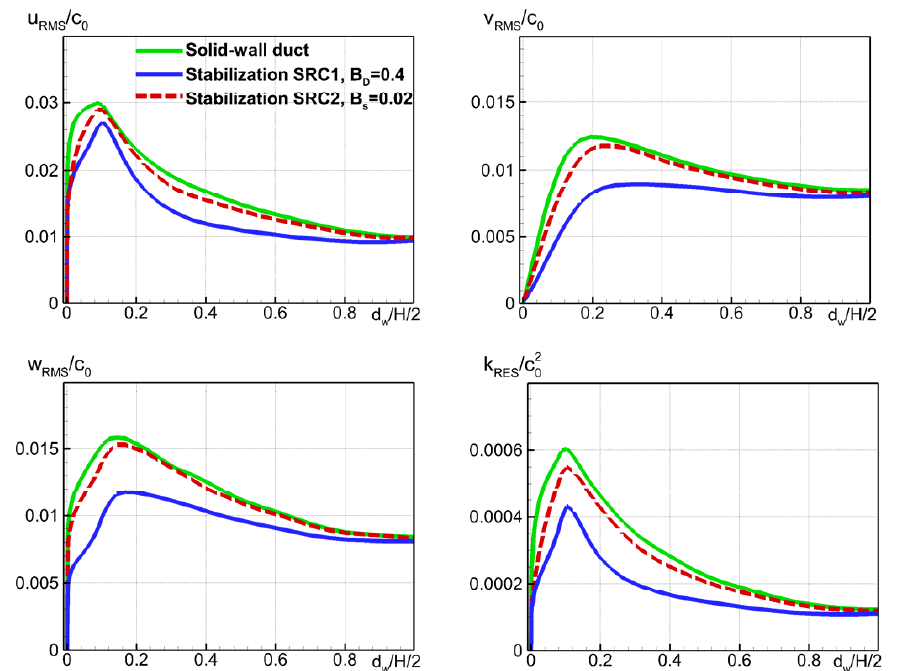
Figure 13. Comparison of wall-normal pro fi les of root-mean-square pulsations of velocity compo- nents and resolved TKE at x = 0.6 m from simulations of fl ows in the solid-wall duct using original governing equations; in the duct with liner using equations with added stabilization body force SRC1 (7) at B D = 0.4; and in the duct with liner using equations with added stabilization body force SRC2 (9) at B s = 0.02.